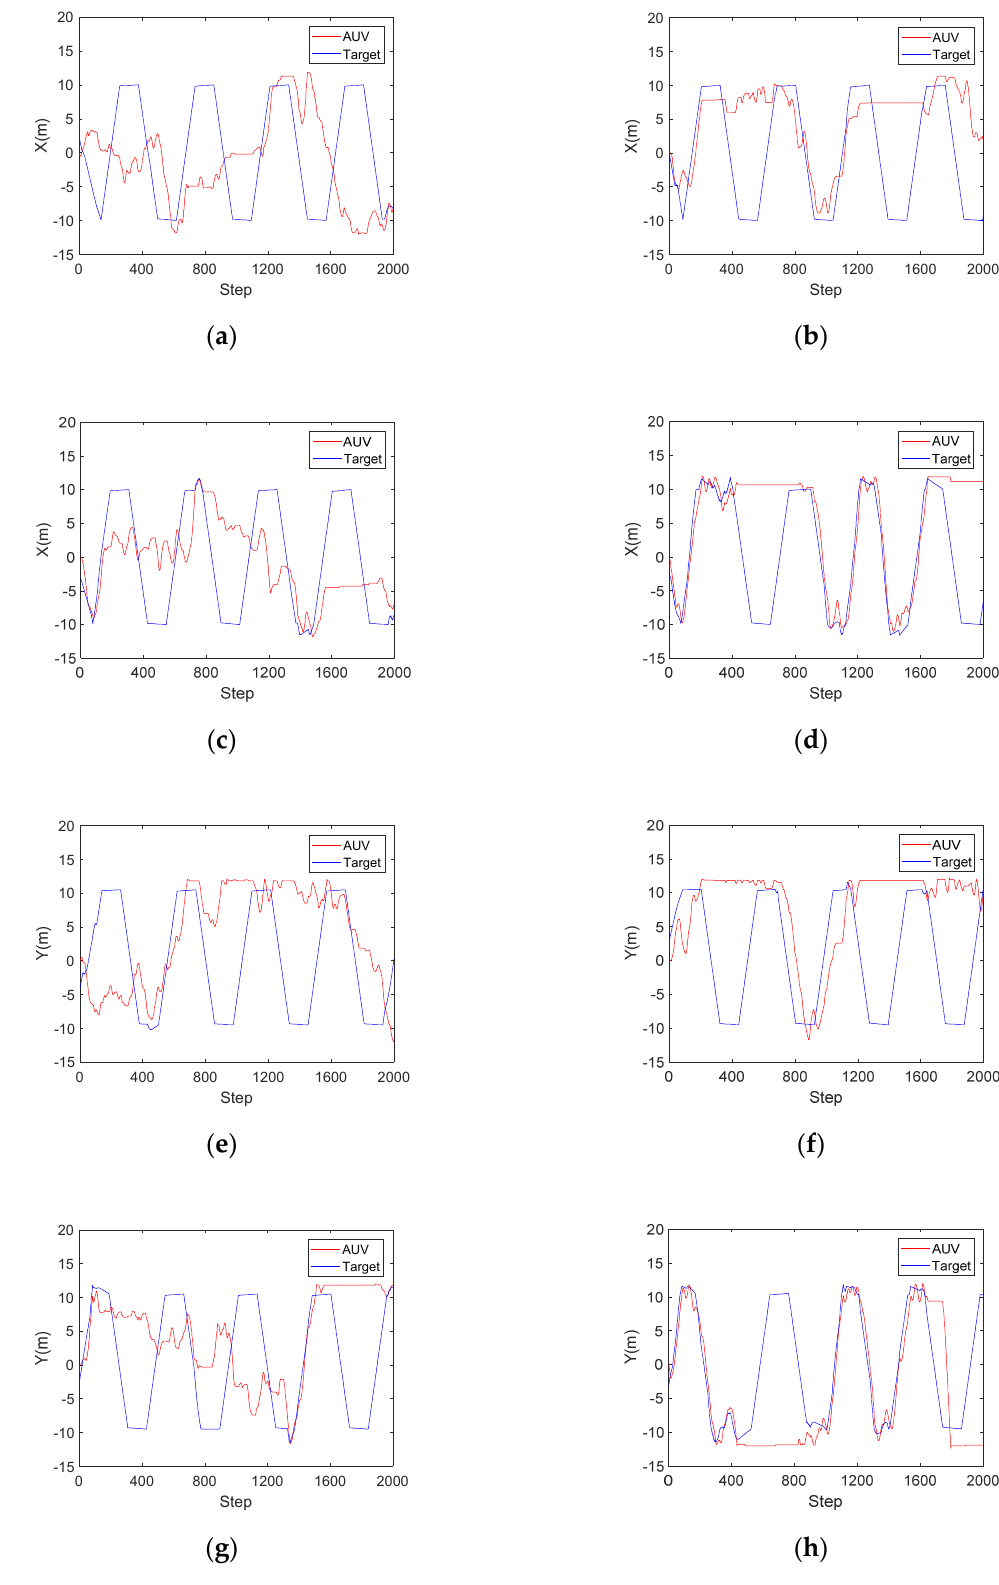
Figure 8. The coordinate change curves in Scene 3 during the process of AUV tracking the target using PPO, SAC, GAIL, and MAG, respectively: ( a – d ) the X-coordinate change; and ( e – h ) the Y-coordinate change.